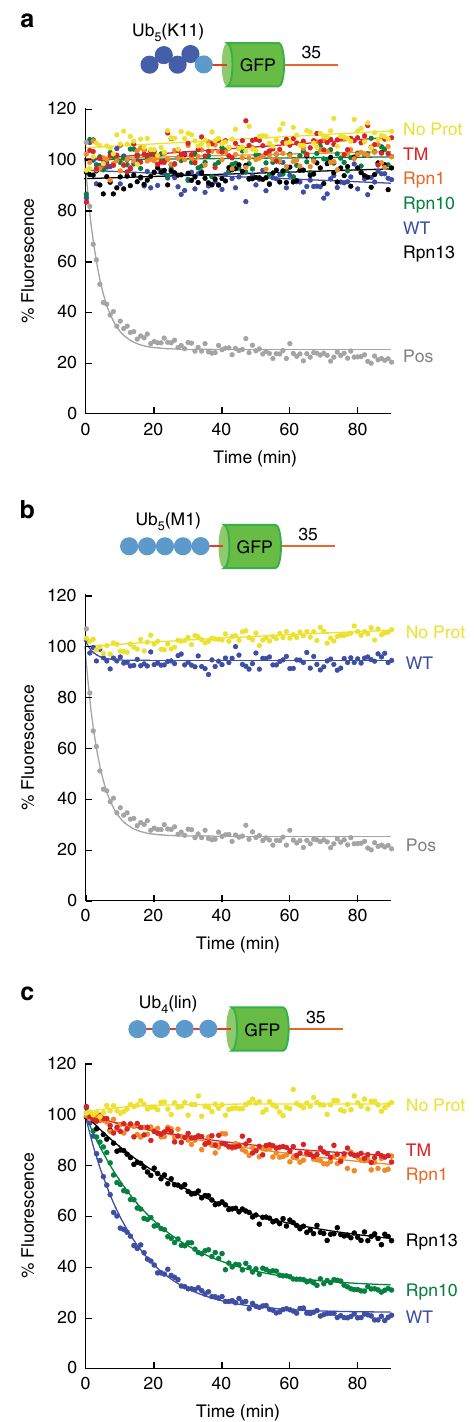
Fig. 4 Degradation of substrates with K11-linked, M1-linked, and linear polyubiquitin chains. Degradation of substrate proteins with the shown ubiquitin chains by the indicated proteasome mutants was followed under single-turnover conditions (5nM substrate, 25nM proteasome) in the presence of 1mM ATP at 30°C. The graphs show substrate fl uorescence as a percentage of the initial fl uorescence as a function of time in minutes.